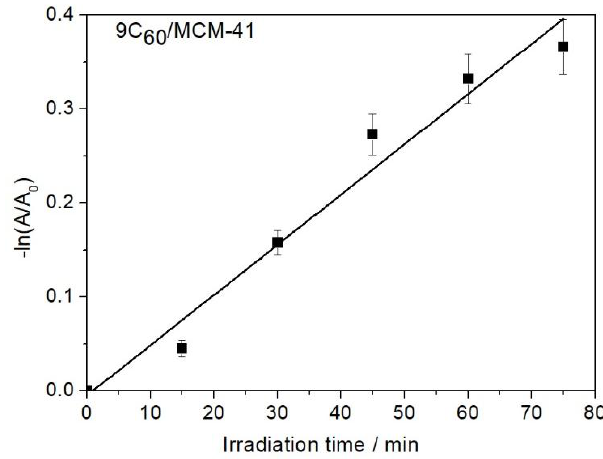
Figure 5. Kinetics of decolorization through irradiation over the photo-catalyst 9C 60 /MCM-41.